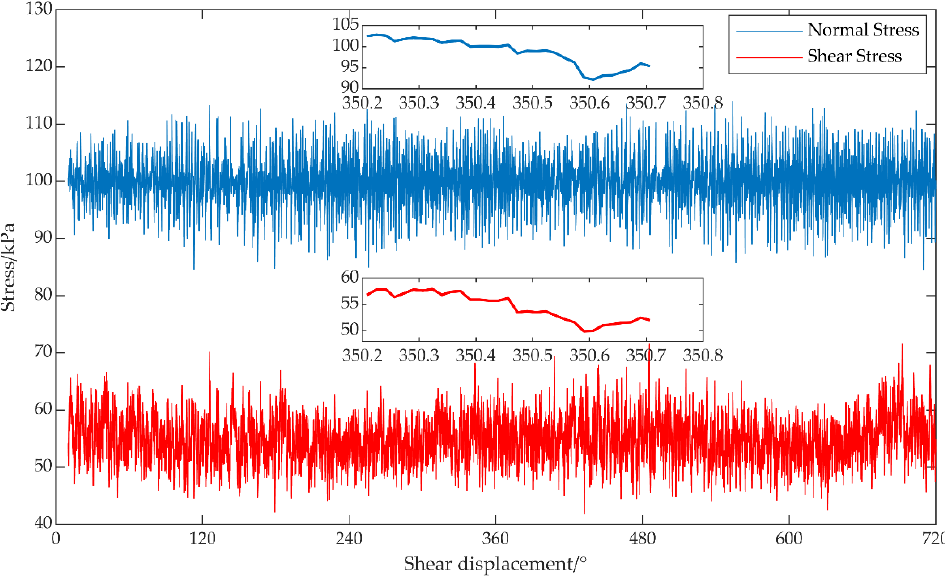
Figure 5. Typical shear stress curves and local magnification. Quartz sand, v = 30°/min.